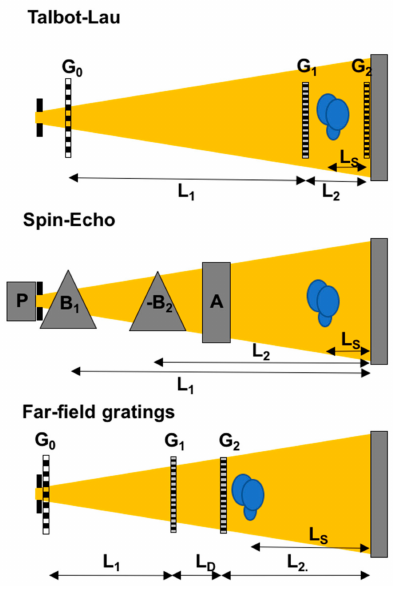
Figure 3. Modulated beam imaging set-ups schematic: Talbot–Lau grating interferometer ( Top ) and spin-echo modulation set-up ( Middle ) as well as a novel development referred to as far-field grating interferometer ( Bottom